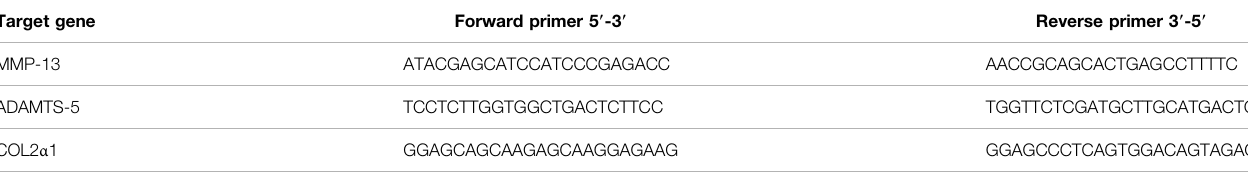
TABLE 1 | Sequences of primers used for qRT-PCR. Target